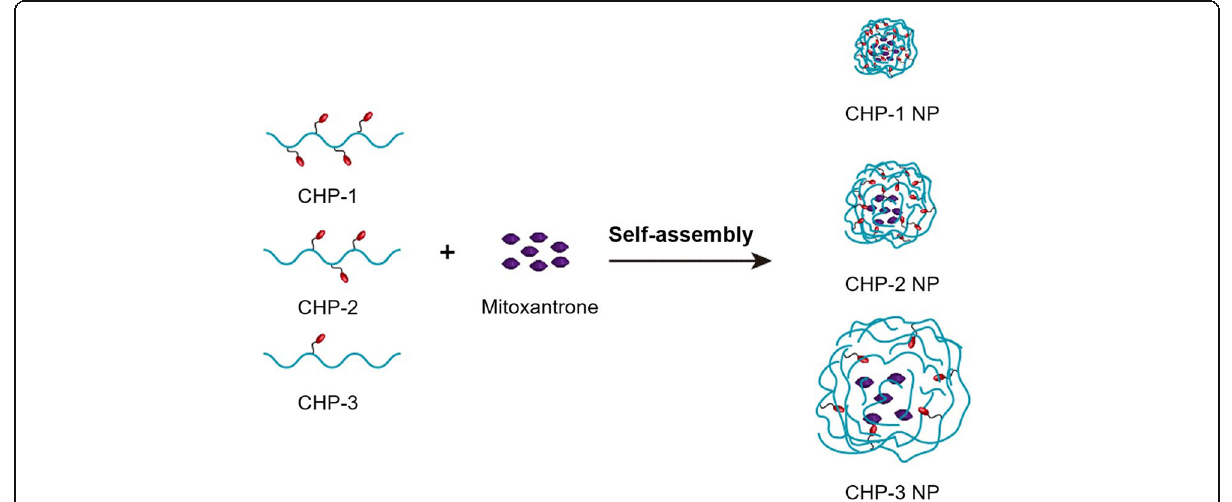
Fig. 8 The self-assembly of mitoxantrone-loaded CHP nanoparticles